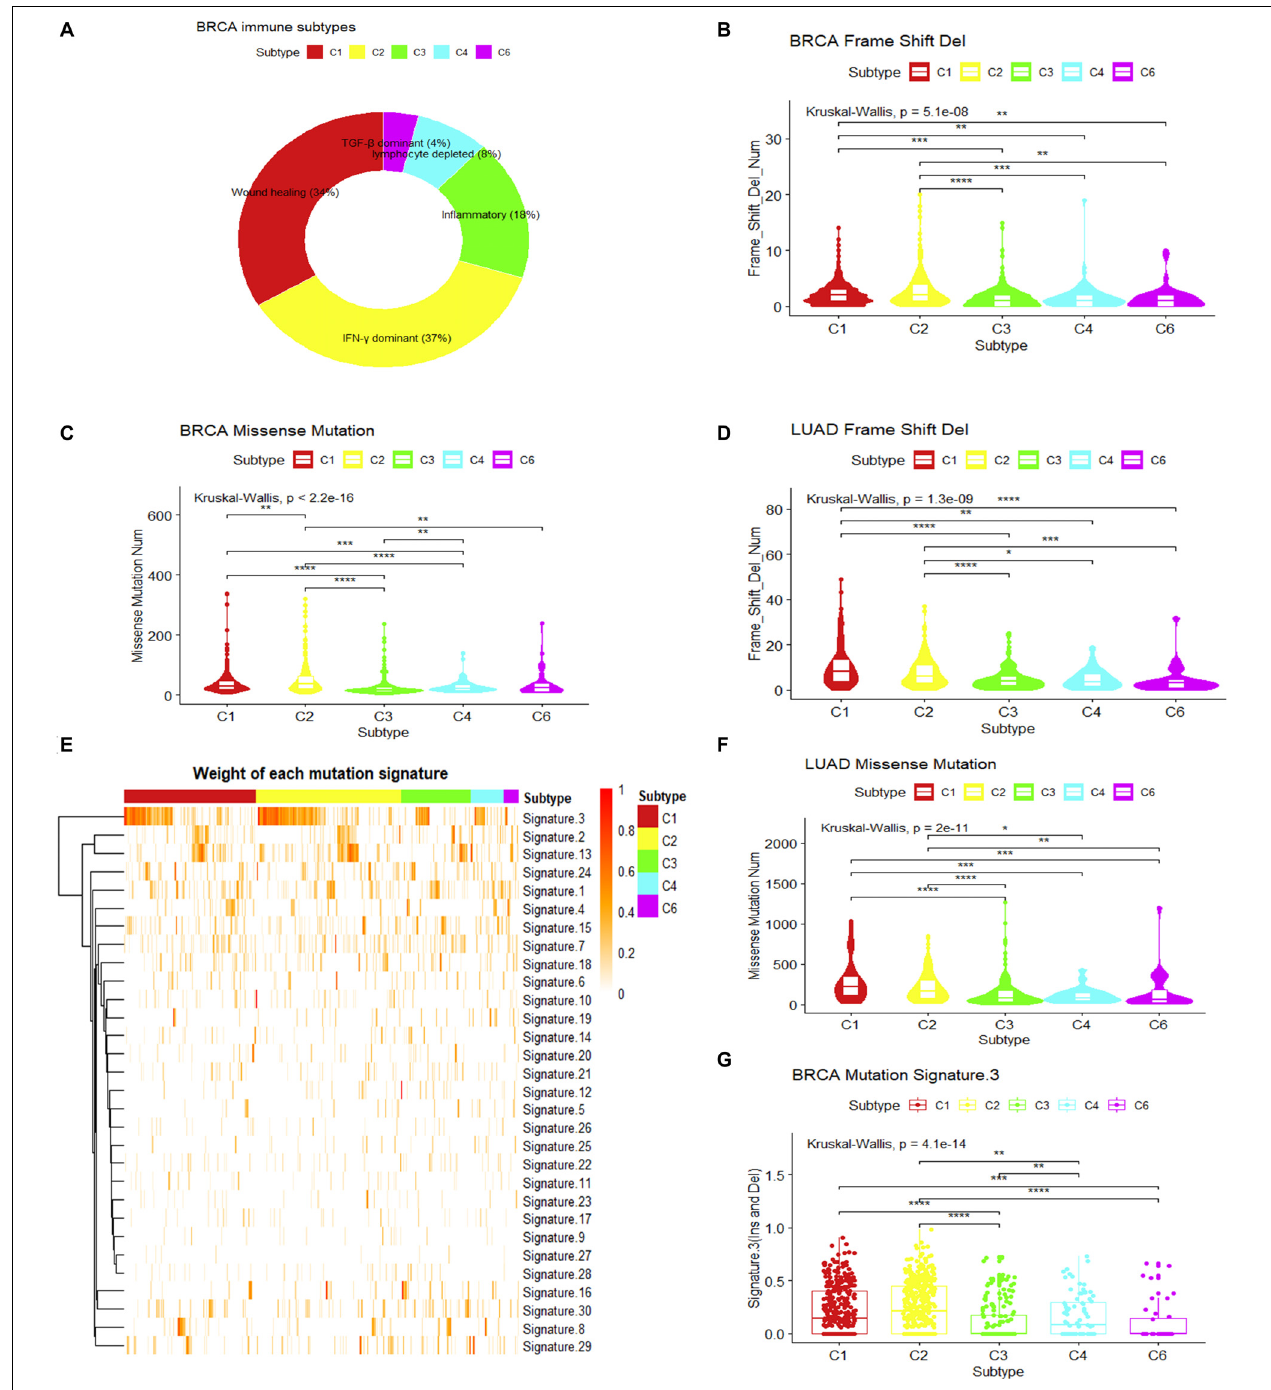
FIGURE 1 | Mutation loads and mutation signatures in immune subtypes. (A) Sample proportions of different immune subtypes in breast invasive carcinoma. (B,C) Comparison of the frequency of frameshift deletion or missense mutation among different immune subtypes of breast invasive carcinoma (Wilcoxon rank-sum test was used. ** P < 0.01, *** P < 0.001, **** P < 0.0001). (D,F) Comparison in the frequency of frameshift deletion or missense mutation among different immune subtypes of lung adenocarcinoma (LUAD) (Wilcoxon rank-sum test was used. * P < 0.05, ** P < 0.01, *** P < 0.001, **** P < 0.0001). (E) The weight of each mutation signature of breast invasive carcinoma immune subtype. (G) The boxplot of the weight of mutation signature 3 for each immune subtype in breast invasive carcinoma (Wilcoxon rank-sum test was used. ** P < 0.01, *** P < 0.001, **** P < 0.0001).